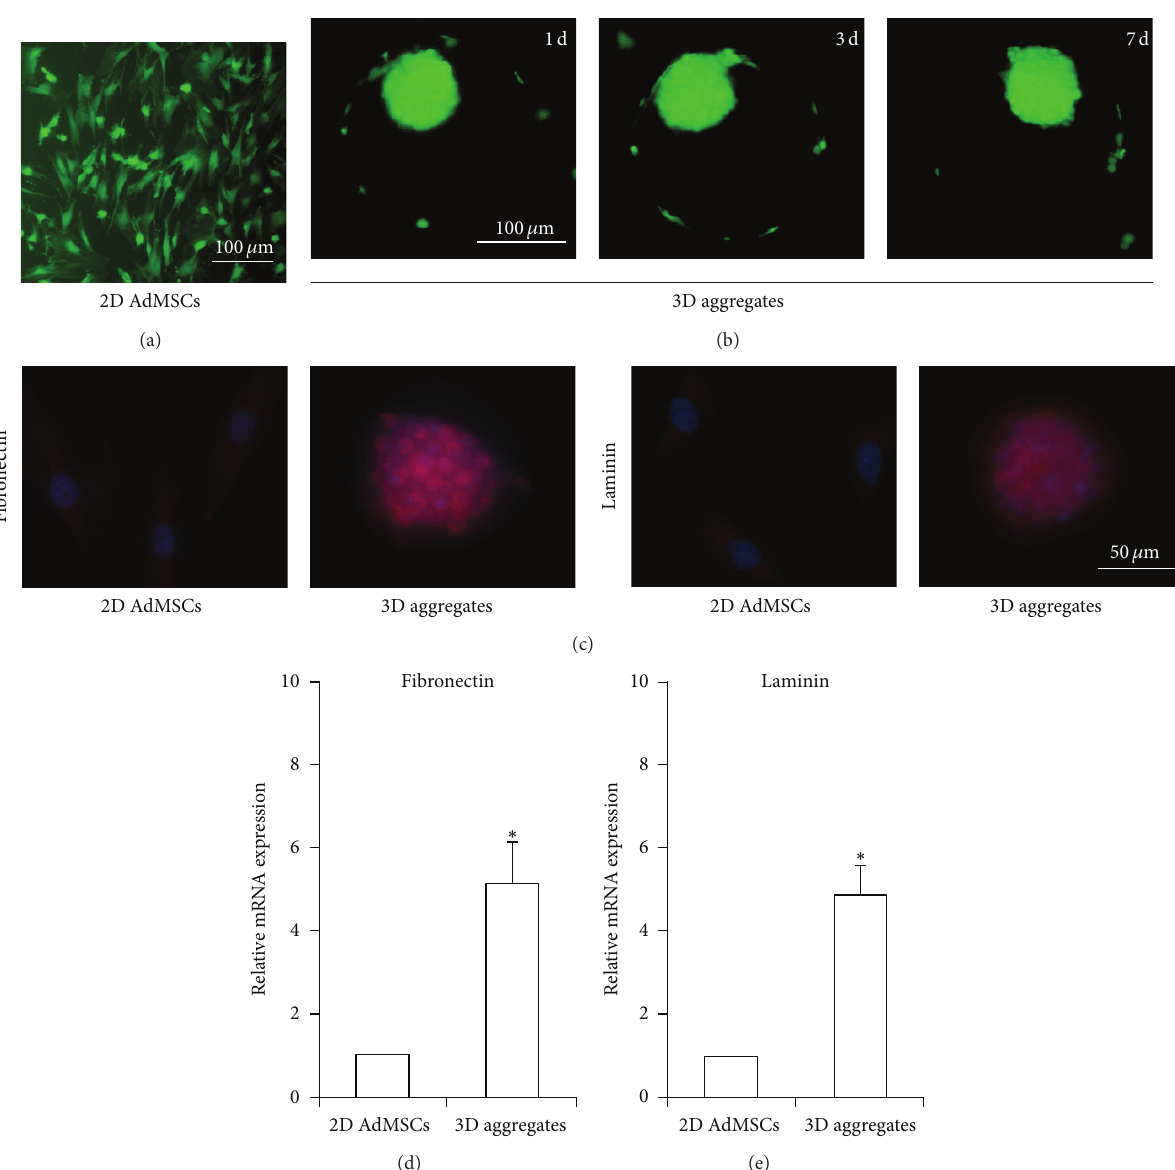
Figure 2: Characters of 3D AdMSCs aggregates. (a) Viability of AdMSCs cultured in 2D monolayer. (b) Viability of 3D AdMSCs aggregates 1d, 3 d, and 7 d after seeding in microwell. Live or dead cells were stained with FDA (live, green) PI (dead, red). (c) Fluorescent images of 2D AdMSCs or 3D aggregates stained with fibronectin and laminin. (d) mRNA expression of fibronectin and laminin in 2D AdMSCs or 3D aggregates. ∗ 𝑃 < 0.05 compared with 2D